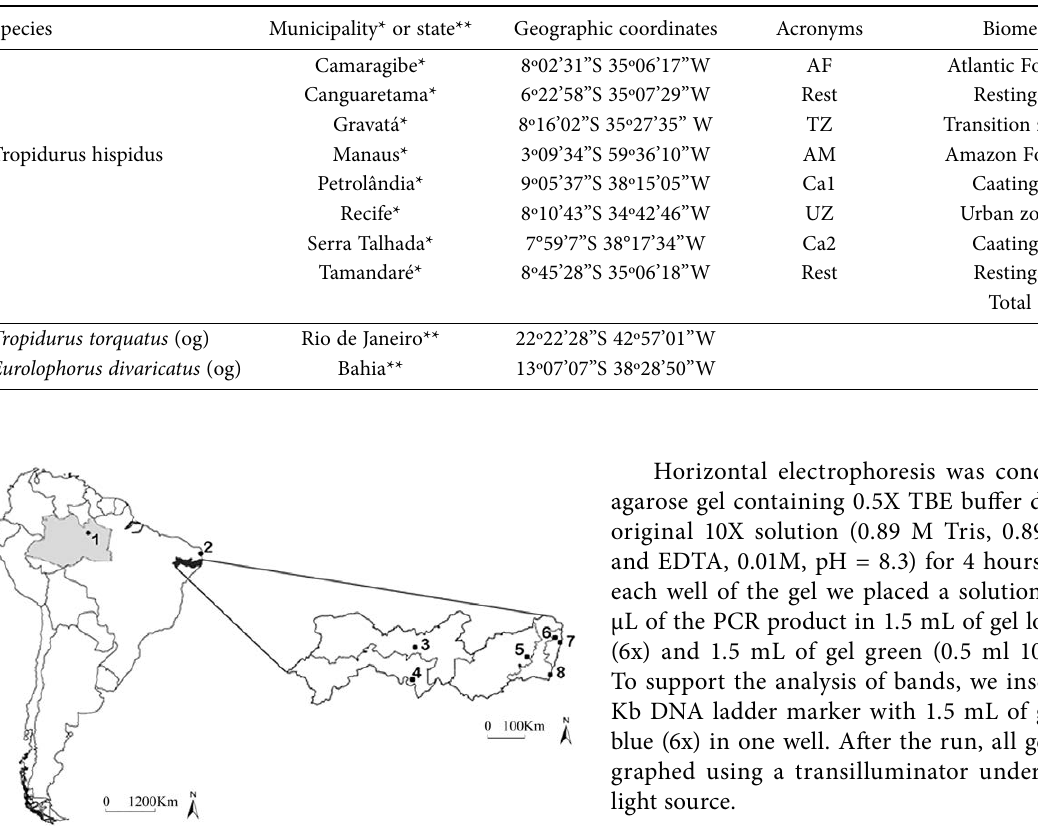
Figure 1. South America/Brazil map depicting capture sites of T. hispidus . In evidence are the different capture sites in Pernam- buco (PE) Brazilian state. The biomes accessed are written here within parentheses as follows: 1. Manaus (Amazon Forest-AM), 2. Canguaretama-state of Paraíba (Restinga-Rest), 3. Serra Talhada (Caatinga-Ca2), 4. Petrolândia (Caatinga-Ca1), 5. Gravatá (Transi- tion zone between Caatinga and Atlantic Forest-TZ), 6. Camara- gibe (Atlantic Forest-AF), 7. Recife (Urban zone-UZ), 8. Tamandaré